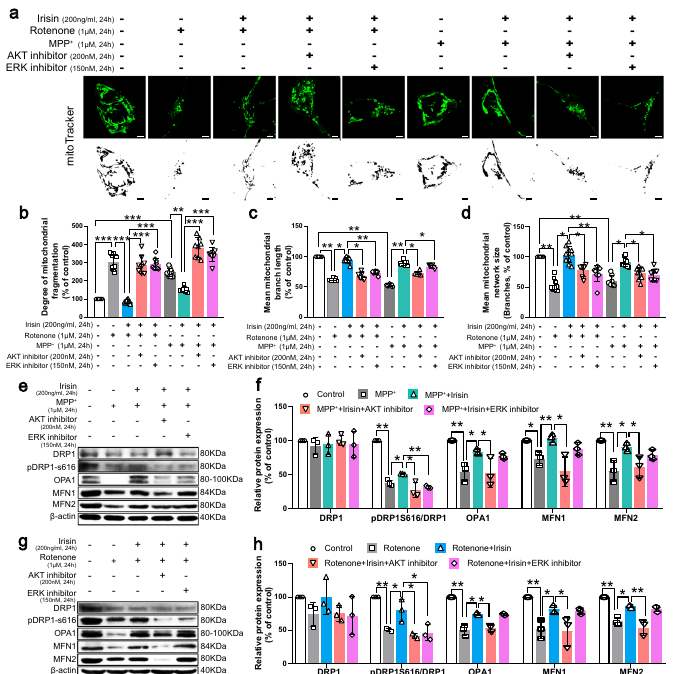
Fig. 10 Irisin restores mitochondrial morphology via activation of Akt and ERK1/2 signaling pathways in PD models induced by neurotoxins. a – d Confocal image and relative quantitative analysis of cell coverslips stained by mitoTracker and its quanti fi cation showing mitochondrial fragmentation in various groups of in vitro experiments. Scale bar, 2 μ m. e , f Western blot showing the quanti fi cation of DRP1, pDRP1-S616/DRP1 ratio, OPA1, MFN1and MFN2 in each group of SH-SY5Y cells treated by irisin, MPP + , Akt inhibitor and ERK1/2 inhibitor. g , h Western blot showing the quanti fi cation of DRP1, pDRP1-S616/DRP1 ratio, OPA1, MFN1and MFN2 in each group of SH-SY5Y cells treated by irisin, rotenone, Akt inhibitor and ERK1/2 inhibitor. All data are presented as mean ± SEM ( n ≥ 3). ∗ p < 0.05, ∗∗ p < 0.01, and ∗∗∗ p <